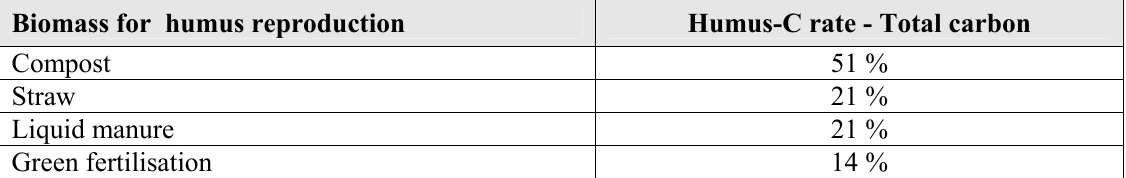
Table 37: The value of organic material types matter for humus reproduction (Kehres 2008) [b19] Biomass for humus